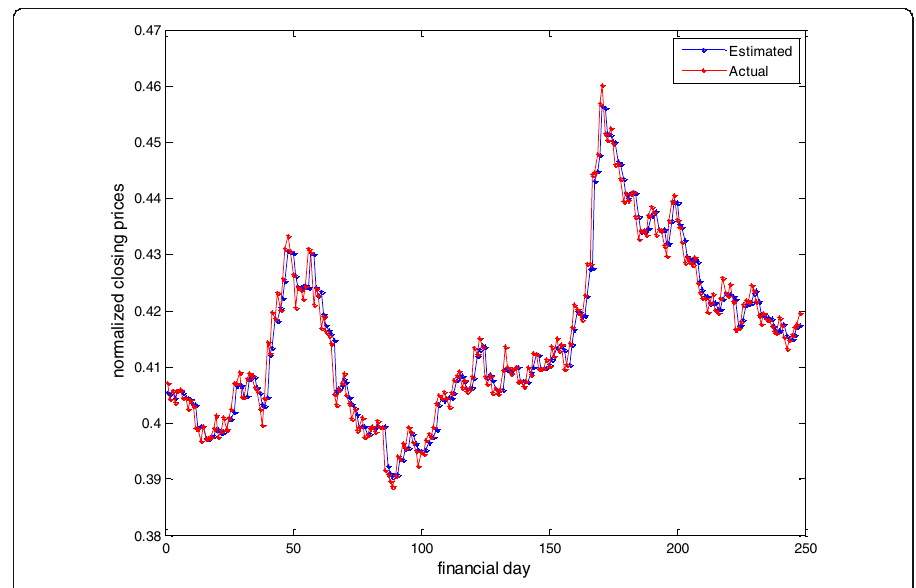
Fig. 7 Actual v/s estimated closing prices by CPNN-GA for DJIA